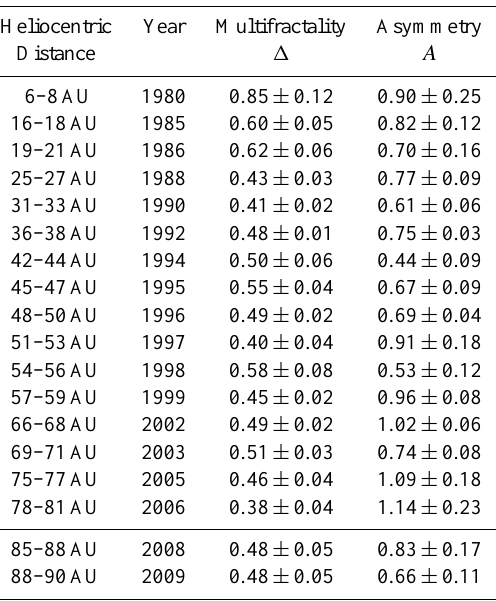
Table 1. Degree of multifractality 1 and asymmetry A observed by Voyager 2 in the heliosphere and the